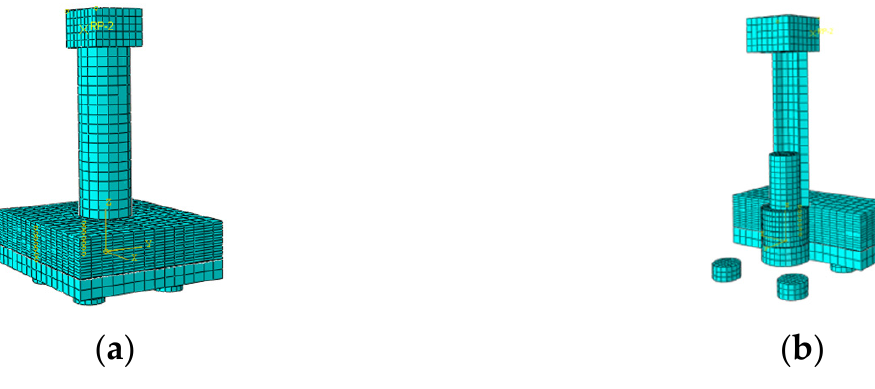
Figure 12. Finite element model of the improved socket connection. ( a ) Precast member; ( b ) sectional view of the model.